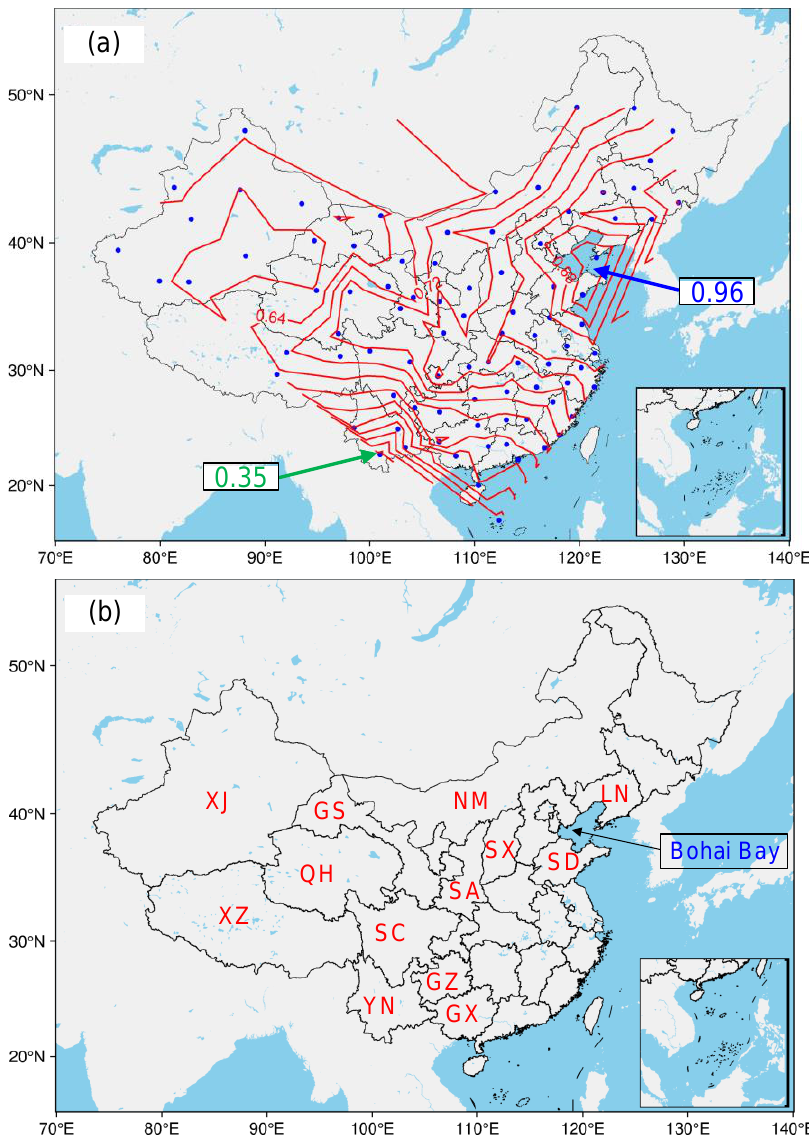
Figure 5. Slopes of T s ∼ T m linear regression models. ( a ) the contour lines of the slopes of the linear models. The contour interval is 0.04. The plot ( b ) provides an area name and the names of provinces (acronym) that are referred to in the text.